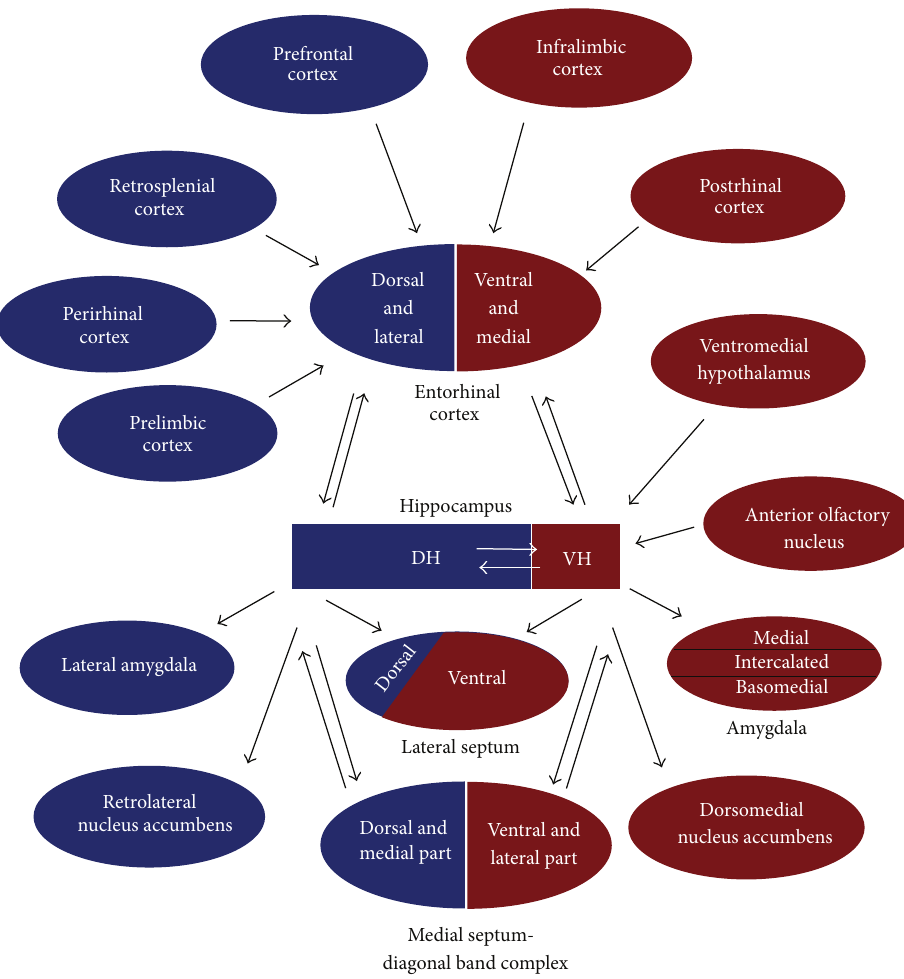
Figure 1: A schematic diagram of the major connections of the dorsal (DH) and ventral (VH) sectors of